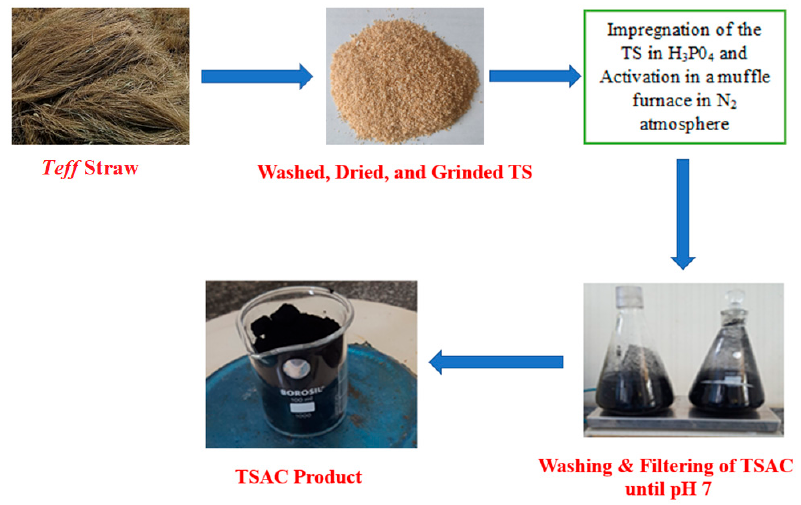
Figure 1. Schematic diagram of TSAC